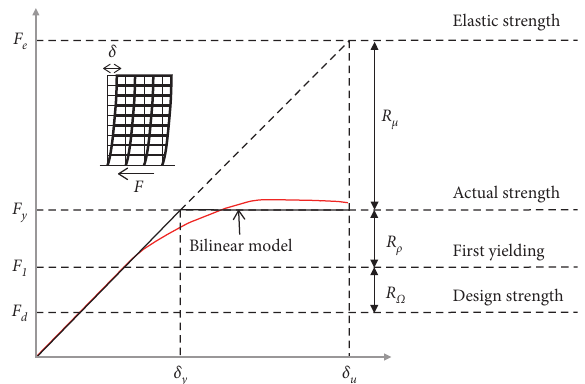
Figure 1: Base shear versus roof displacement relationship. Over- strength ( R Ω ), redundancy ( R ρ ), and ductility ( R μ ) reduction